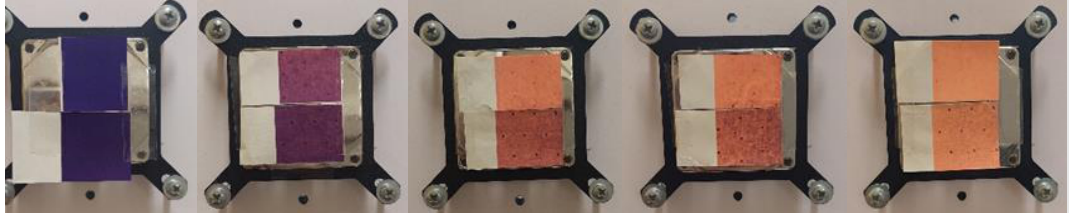
Figure 11. Visual presentation of thermochromic prints of cold activated TC ink OY-12 at 20 °C, before and after exposure of samples to UV radiation (6, 12, 18, and 24 h) (above CHR sample, below NMF sample).